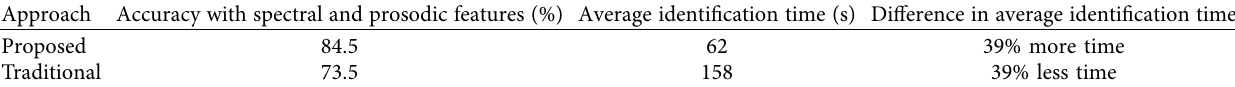
Table 10: Identification time of the proposed approach vs traditional